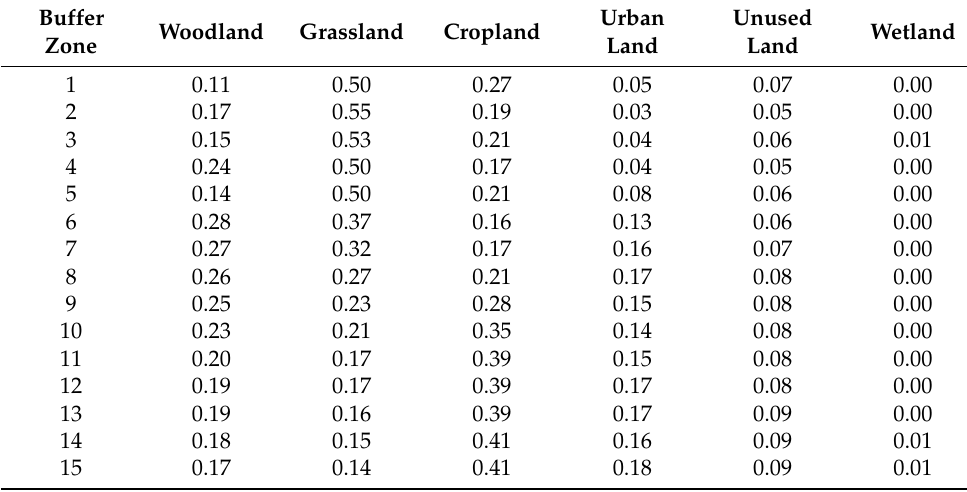
Table 3. Proportion of land use types in the Yongding River